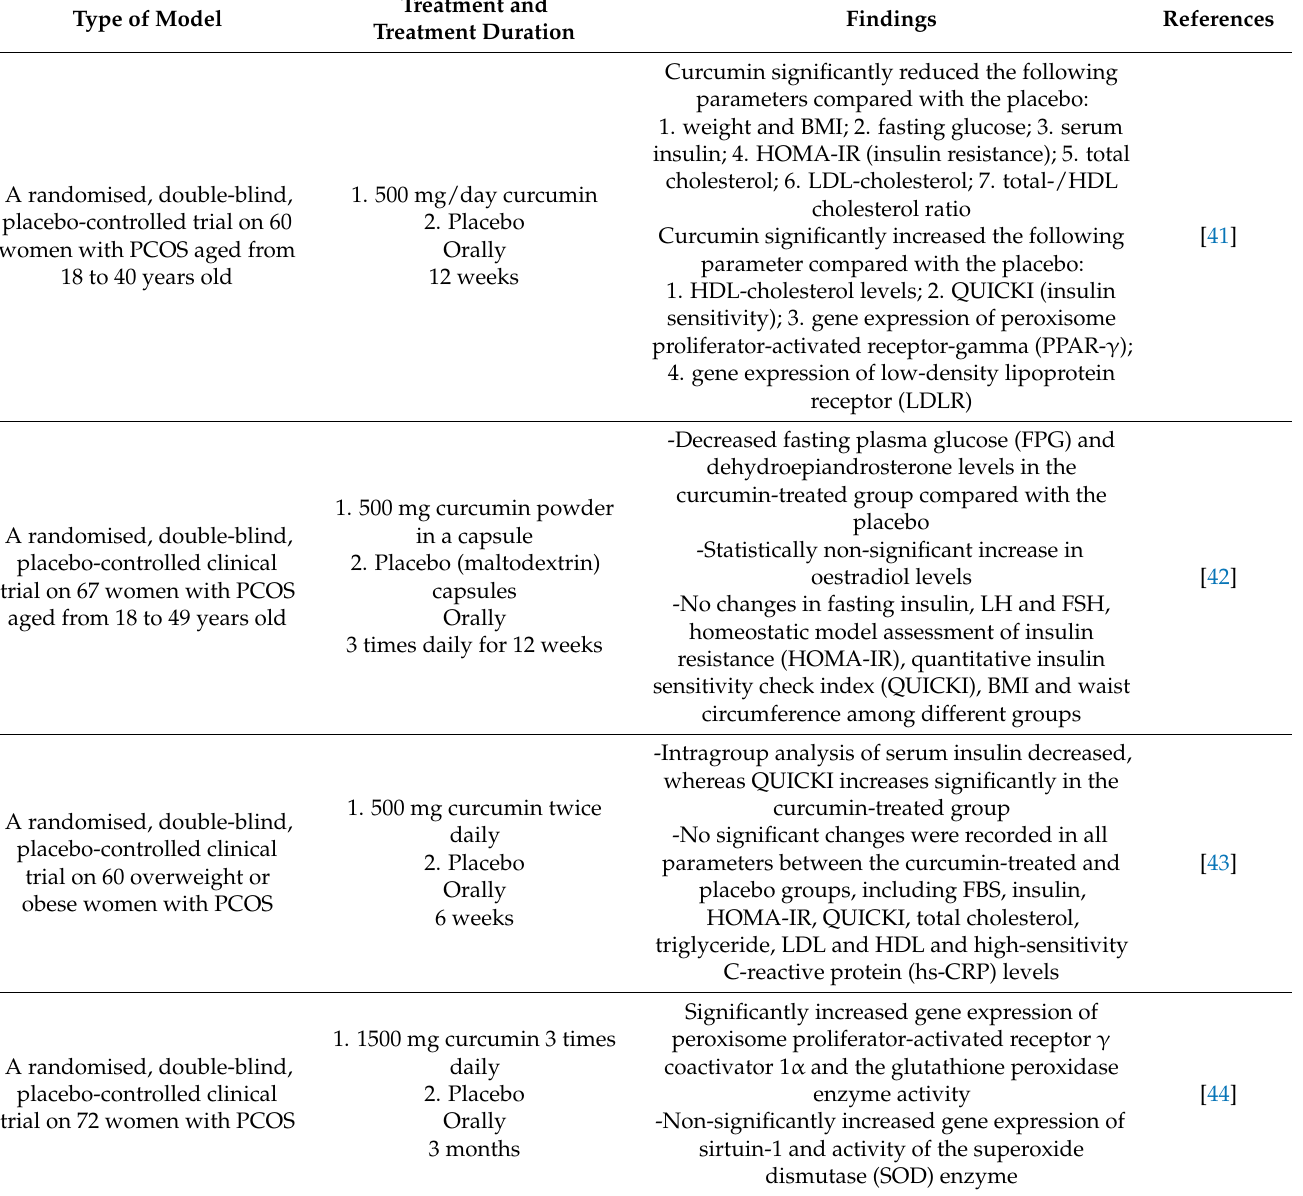
Table 1. Summary of the effects of curcumin on PCOS in